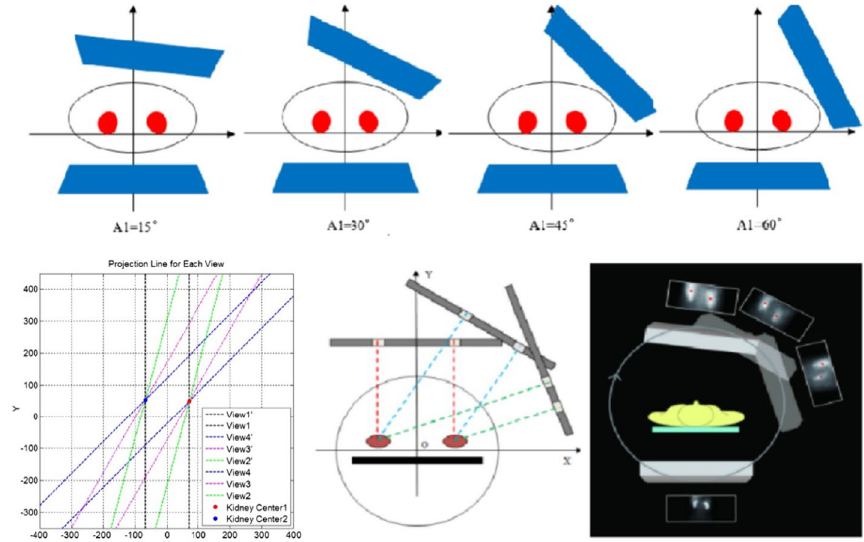
Fig. 1 Schematic diagram of the rotation method. The process of acquiring the kidney projection image at different angles is shown. The projection image is segmented to obtain the center of gravity of the kidney projection at different sampling angles for calculating the spatial position of the center of gravity of the kidney projection, and then, calculating the projection line of the center of gravity of the kidney projection at different sampling angles based on the spatial position of the center of gravity of the kidney projection. The intersection of the projection line of the center of gravity of the kidney projection at all sampling angles is